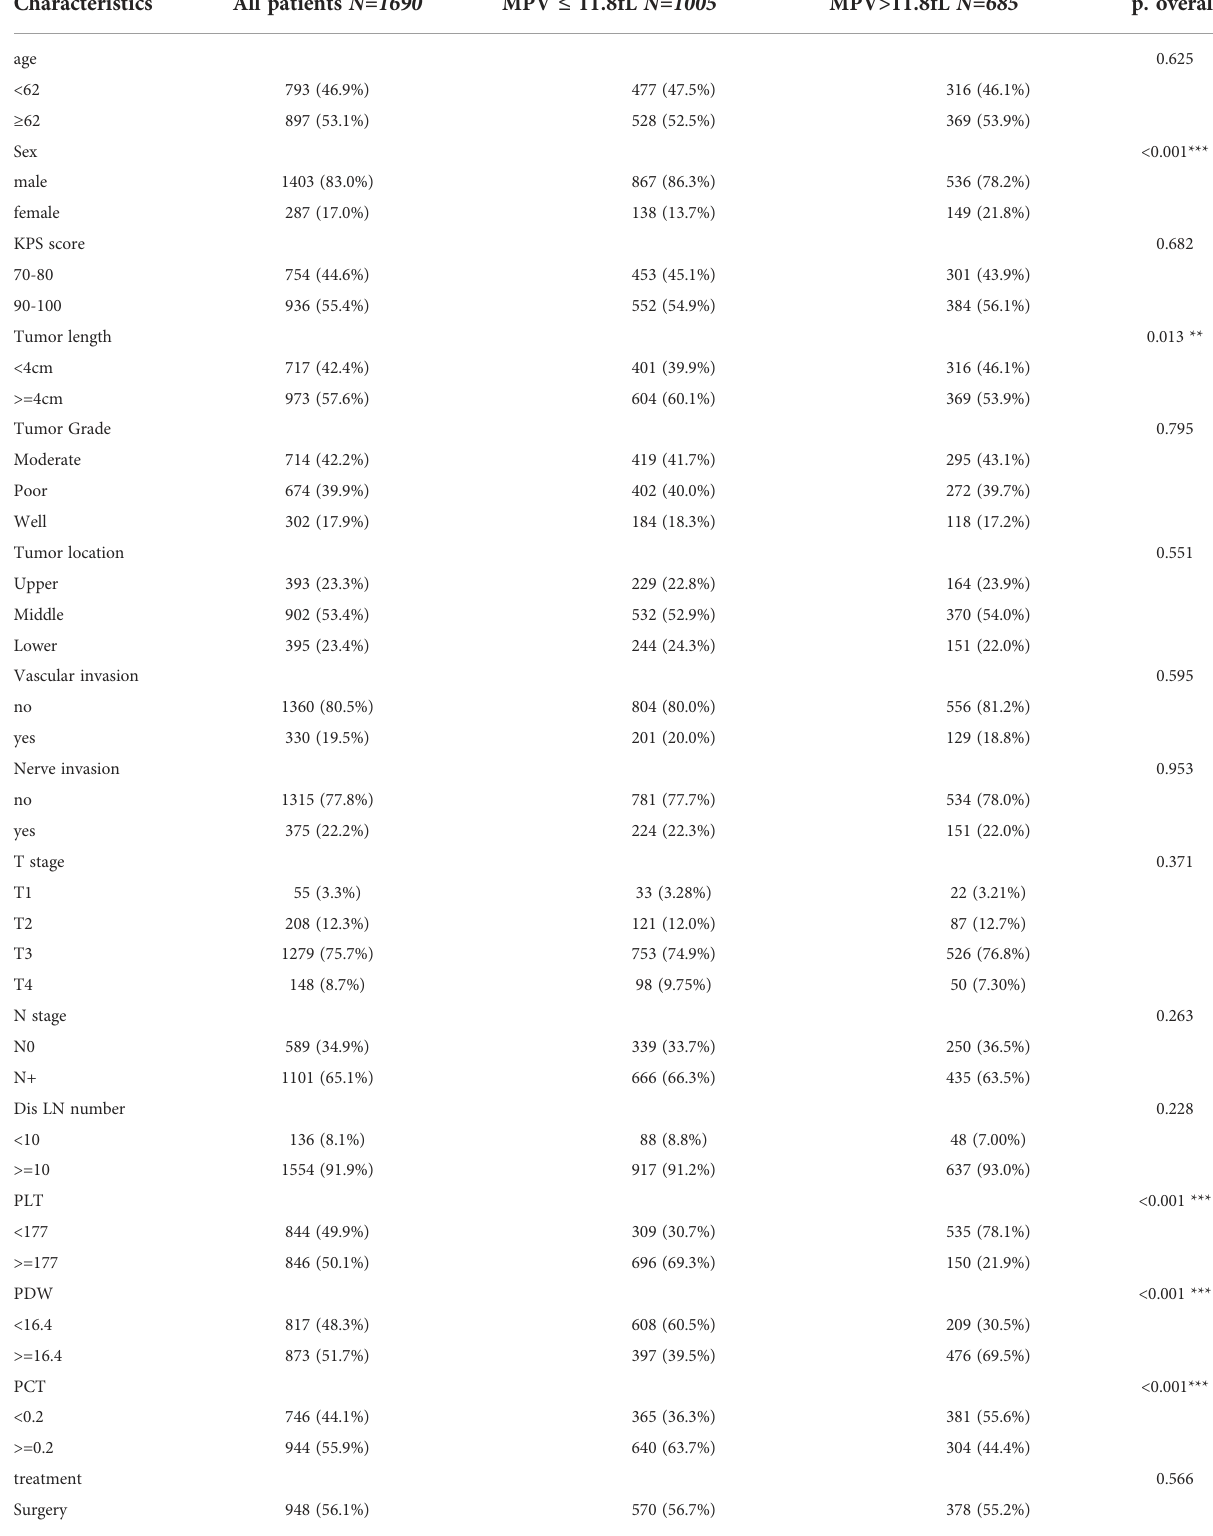
TABLE 1 Clinico-pathological characteristics of local advanced stage ESCC by MPV